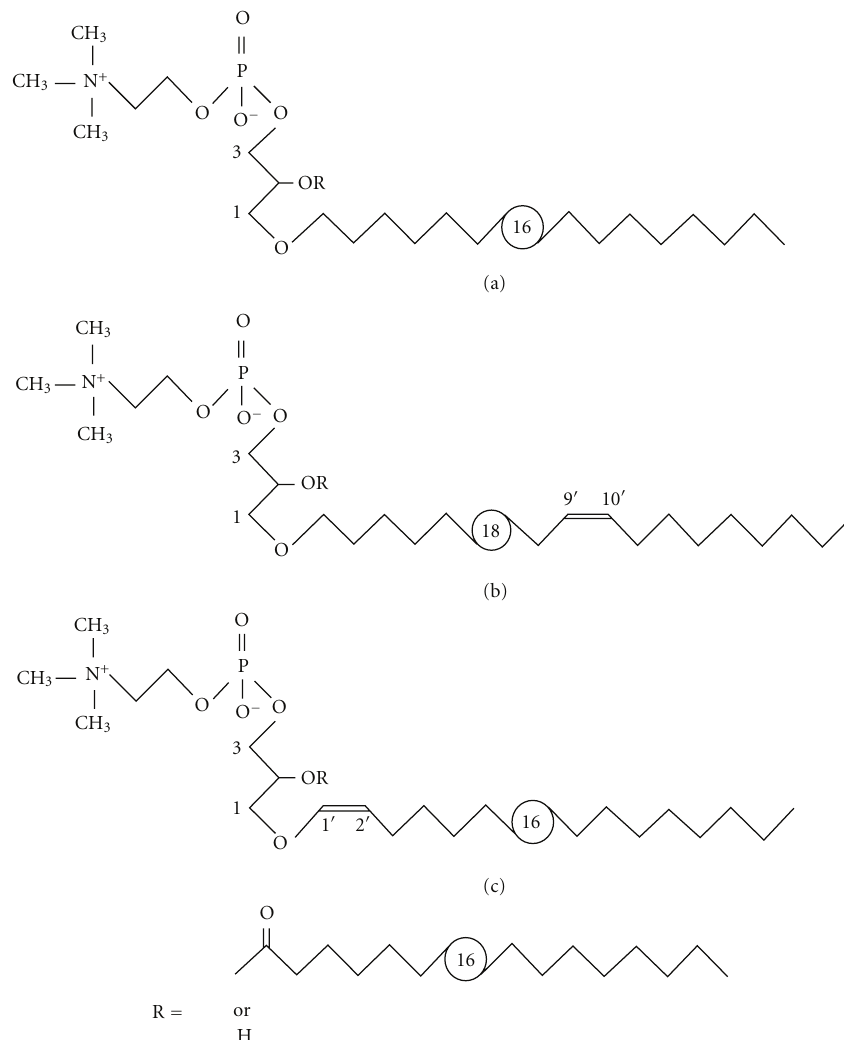
Figure 3: Structures of ether lipids of M. fermentans . Both MfEL (R = acyl) and lyso-MfEL (R = H) are mixtures of di ff erent molecular species with respect to the alkyl/alkenyl residues which are hexadecyl (a), ( 9Z )-octadec-9 (cid:2) -enyl (b), or ( 1Z )-alk-1 (cid:2) -enyl (c) [37].